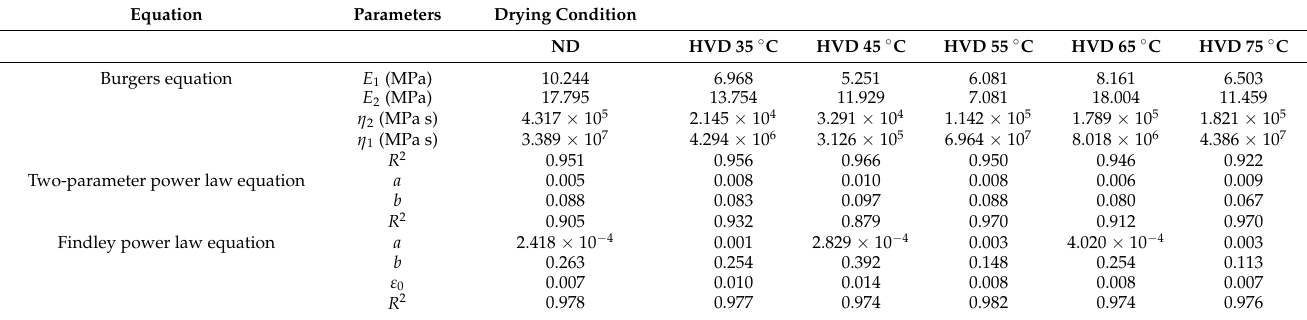
Table 6. Equation parameters for long-period creep of maize